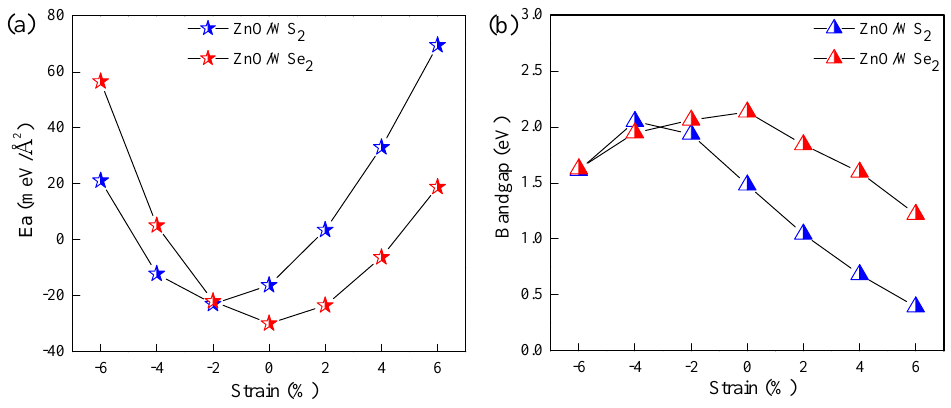
Figure 4. ( a ) Interface adhesion energies and ( b ) bandgaps of ZnO/WS 2 and ZnO/WSe 2 with different strains.